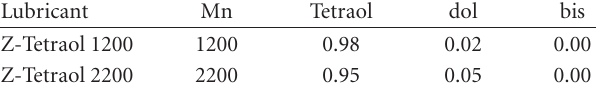
Table 1: NMR data for the PFPE